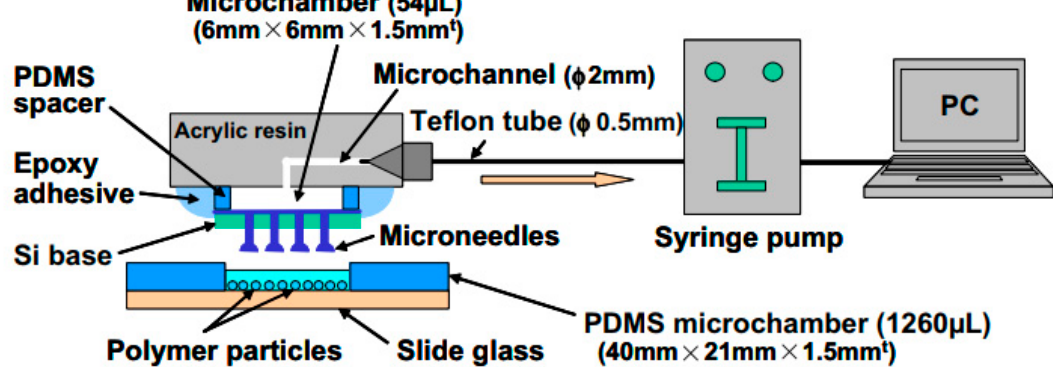
Figure 25. Overview of the system designed by Shibata et al. “Reprinted with permission from